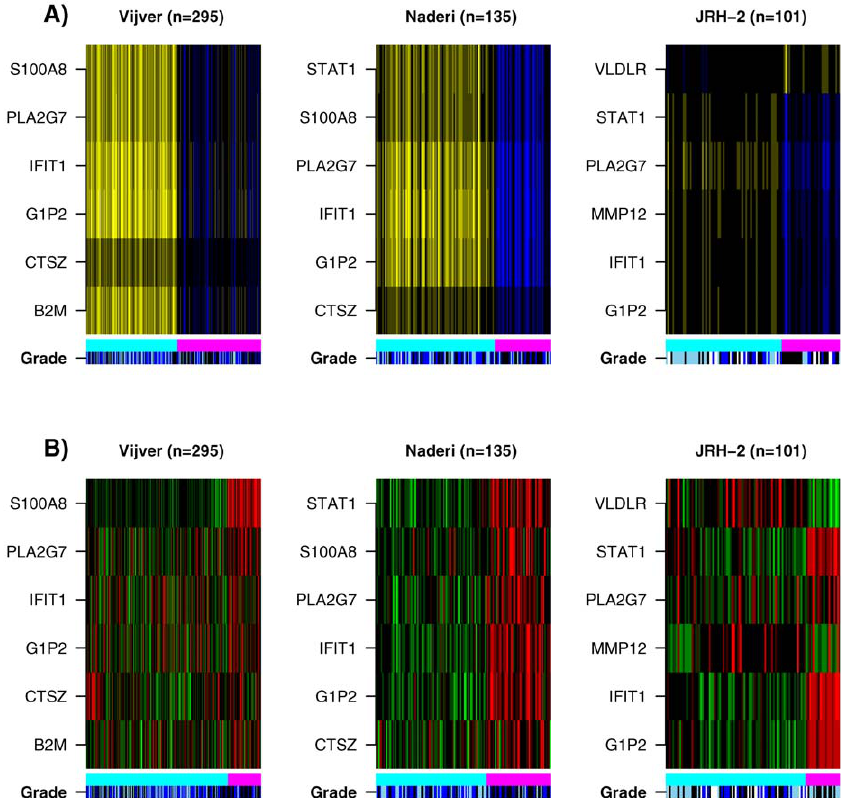
Figure 6. The Association of Epithelial–Mesenchymal Transition with Histological Grade (A) For each major breast cancer cohort where grade information was available, we give the heatmap of component expression values for the component enriched for the EMT pathway characterised in [41]. Thus, the heatmap matrix shown is S gk A ks where k is the component enriched for the EMT pathway, g is any gene found on the array that is also in the pathway and the selected feature set of the component, and s denotes the tumour sample. The ICA algorithm for which this heatmap is shown is the KernelICA algorithm. Samples have been ordered according to a k-means (k ¼ 2) clustering over the set of genes. Blue denotes ‘‘ upregulation, ’’ yellow ‘‘ downregulation. ’’ For the samples, histological grade is colour-coded as black (high-grade), blue (intermediate grade), and skyblue (low-grade). (B) For each major breast cancer cohort, we give the heatmap of expression values for the same set of genes as in (A). Thus, the heatmap matrix shown is X gs where X gs denotes the measured expression level of gene g in sample s . As before, samples have been ordered according to a hierarchical clustering over the represented genes. Red denotes relative overexpression, green underexpression. Magenta denotes the upregulated cluster, cyan the downregulated cluster.